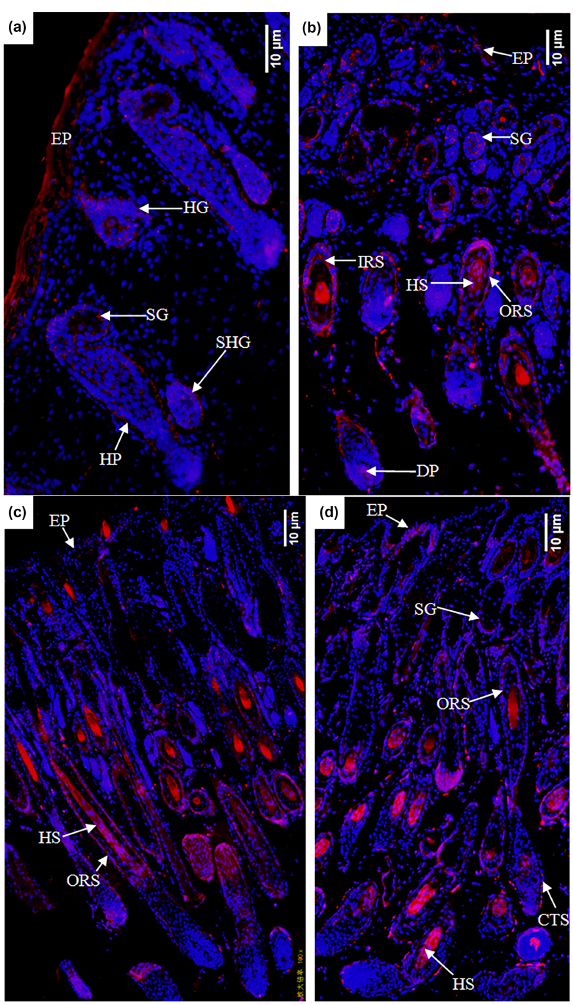
Figure 6. Expression characteristics of the EPHA4 protein in the skin of fine-wool sheep at the different developmental stages: (a) E90d group (200 × ), (b) E120d group (200 × ), (c) B1d group (100 × ), and (d) B30d group (100 × ). All samples were col- lected from the skin on the body side. EP stands for epidermis, HG stands for hair germ, HP stands for Hair peg, SHG stands for sec- ondary follicle germ, HF stands for hair follicle, DP stands for der- mal papilla, CTS stands for connective tissue sheath, HS stands for hair shaft, ORS stands for outer root sheath, and SG stands for se- baceous gland.